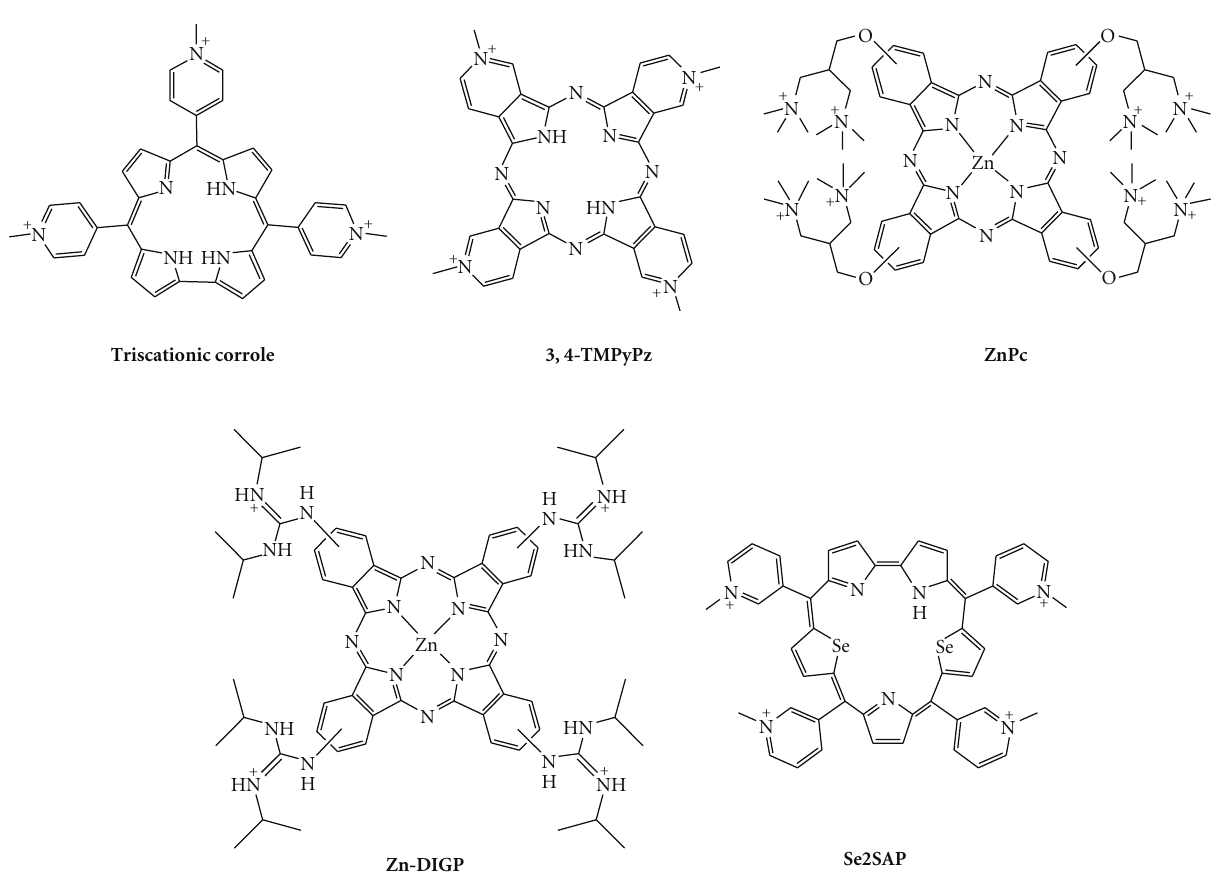
Figure 9: Chemical structures of corrole-, porphyrazine-, phthalocyanine-, and sapphyrin-based G-quadruplex ligands.